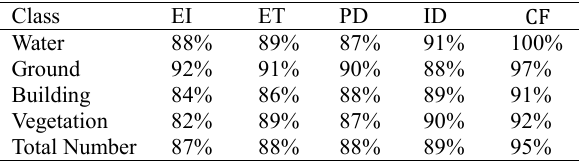
Table 3. Accuracy results of identification The coastline is extracted by ground and water binary images. In the experimental results, the confusion matrix comes from the experimental classifier. In the meanwhile, the accuracy of water and land division is verified, therefore, the coastline can be extracted successfully. In addition, the coastline obtained from deep learning classification is further compared with that obtained by DTM to verify the feasibility as Table 4.